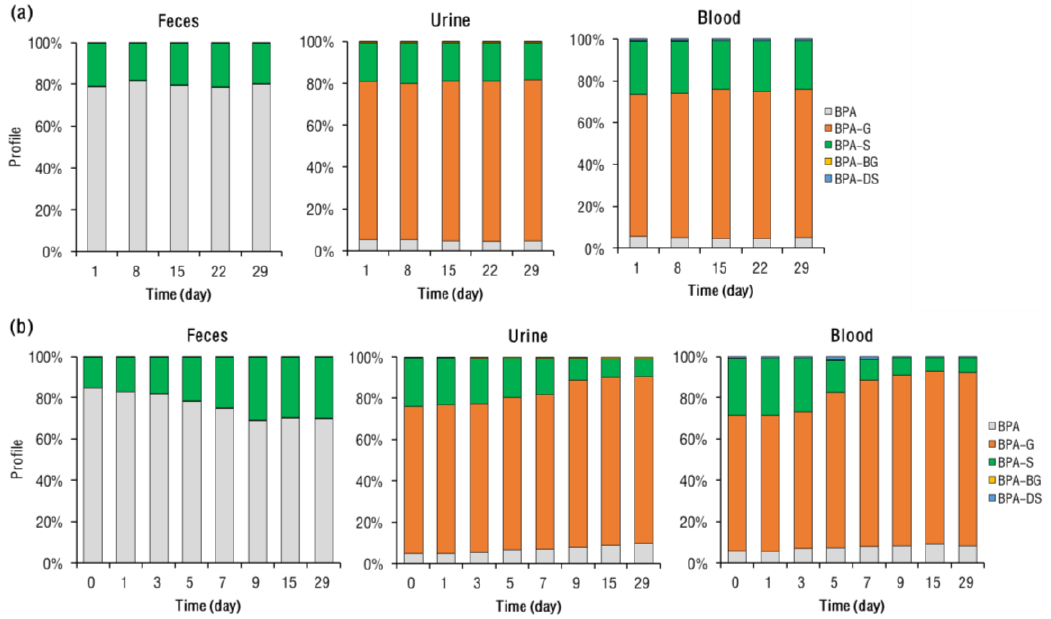
Figure 4. Change in the molar concentration profile of BPA and its conjugated metabolites in feces, urine, and blood of SD rats over time, following ( a ) intervallic and ( b ) continuous oral BPA exposure.